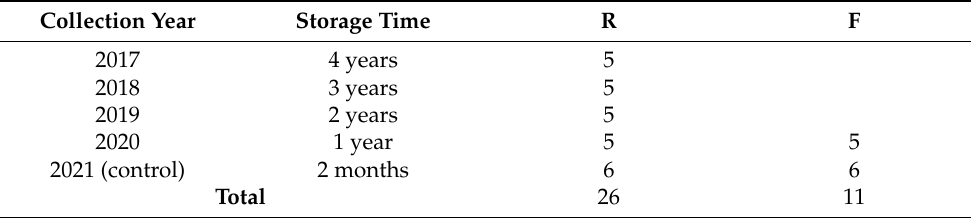
Table 1. Relative amount of RJ samples investigated per treatment (4 ◦ C, refrigeration “R”; − 18 ◦ C, deep-freezing “F”); each of two months and one-year-old sample was analyzed both for R and